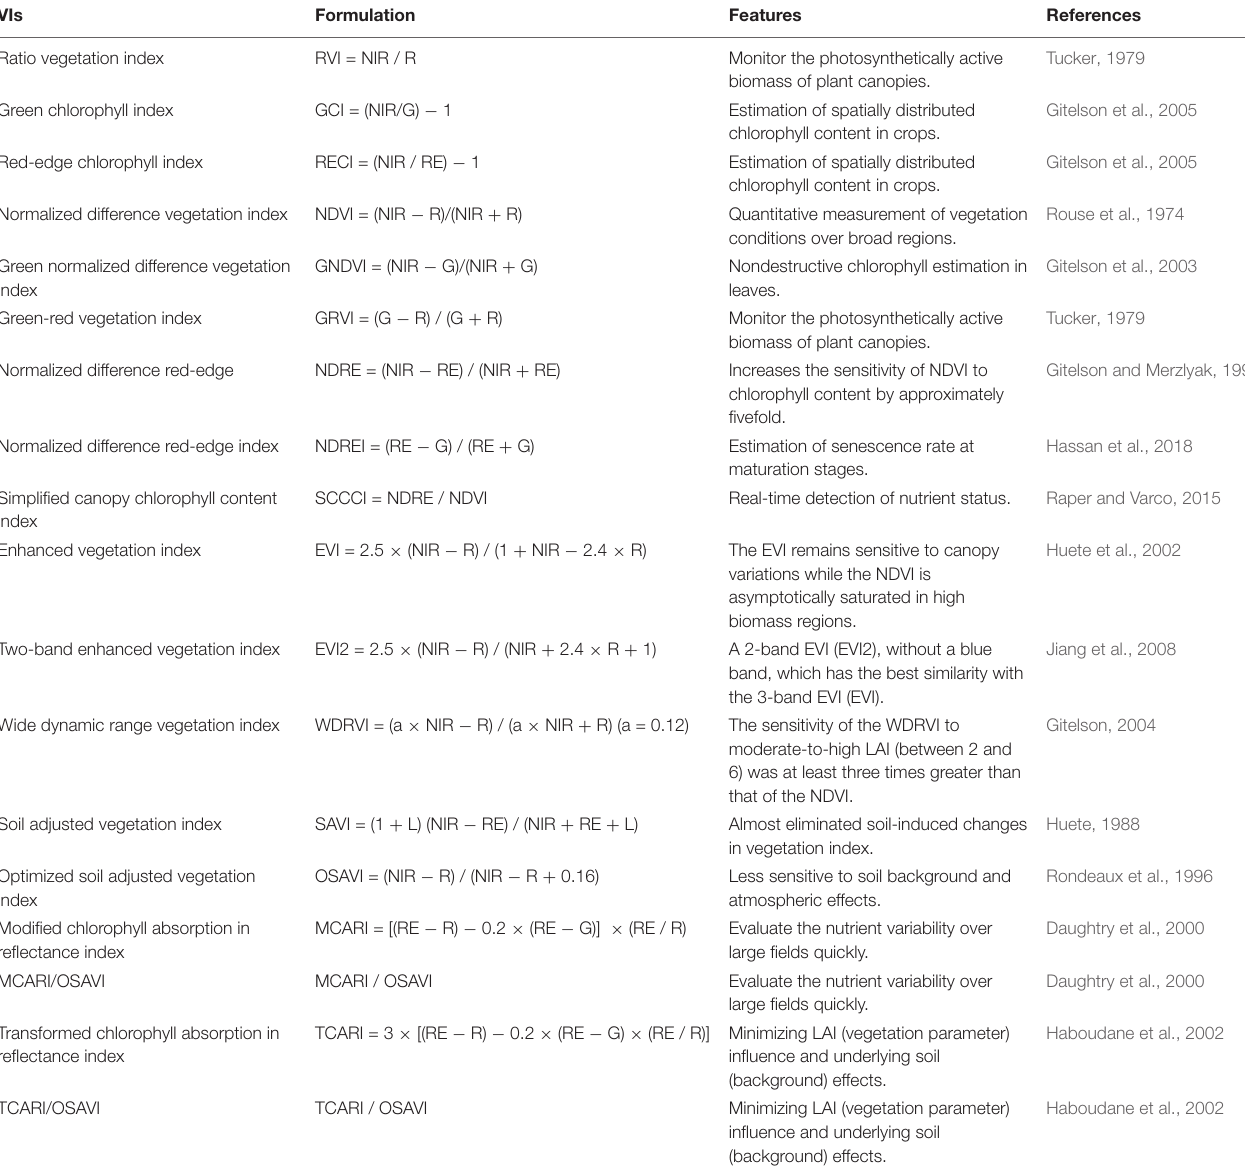
TABLE 1 | Introduce the formulation and features of common